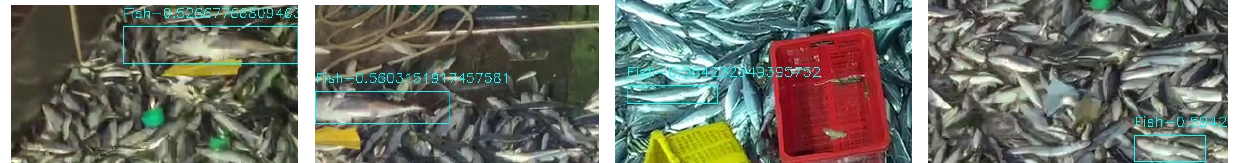
Figure 7. Details of prediction results for the first quadrant image.